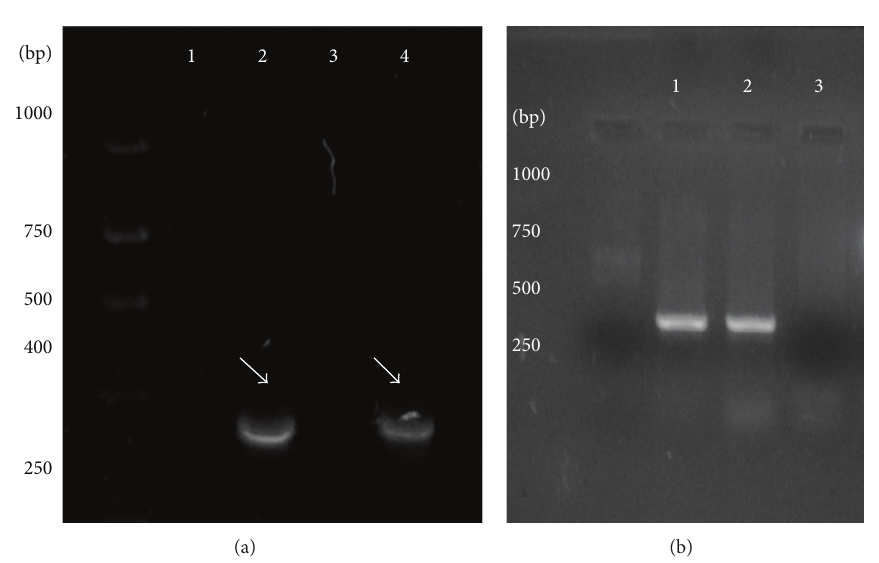
Figure 2: PCR amplification of the APS from (a) P. ovata and (b) P. lagopus . (a) The migrating bands for the 5S rRNA sequence PCR amplified from the genomic DNA of P. ovata . Lanes 2 and 4 show the 350 bp band corresponding to the PCR amplified APS. Lanes 1 and 3 served as control. In (b) lane 3 served as control and 350 bp bands in lanes 1 and 2 correspond to the PCR amplified 5S rRNA sequence. M is the 100 bp DNA